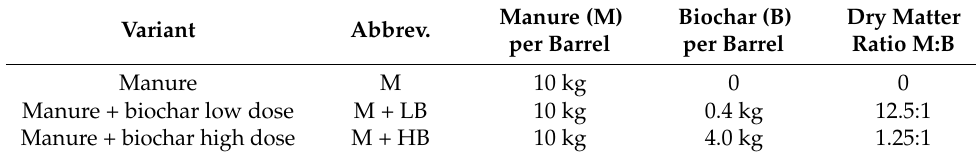
Table 1. Manure variants and additives dosage.